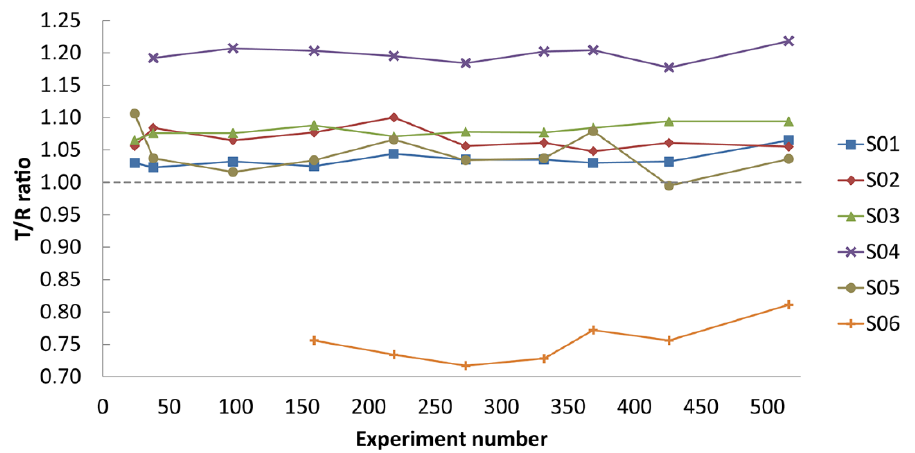
Figure 3. Stability of the screening. A control mixture of five or six compounds was repeatedly injected during the full course of the TINS screening (516 experiments) to monitor the stability of the immobilized proteins. The T/R ratio of these fragments showed no significant increase or decrease over time, from which we conclude that the protein in the sample holder was stable and properly folded during the entire experiment.